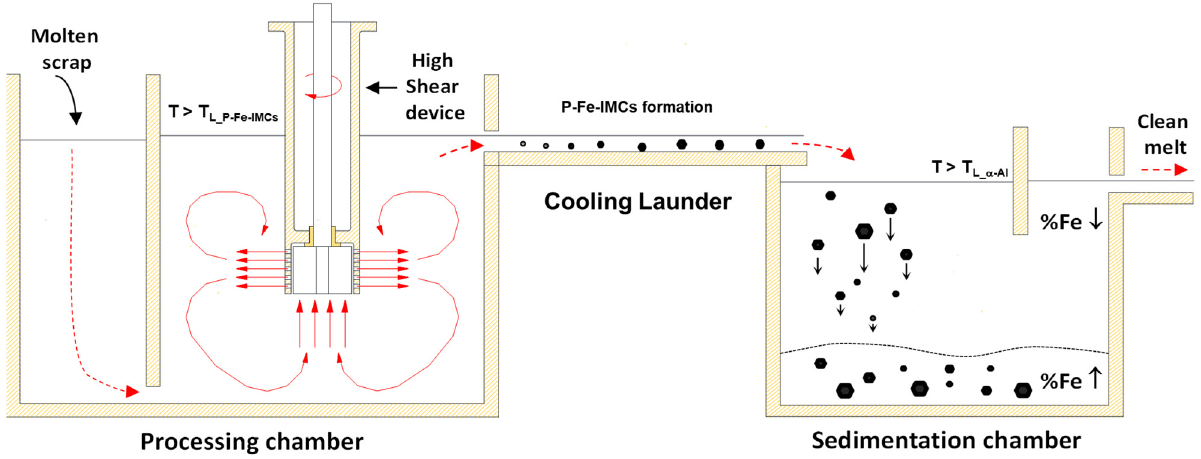
Figure 2. Schematic of the high shear melt conditioning (HSMC) technology for batch and continuous processing of aluminium alloy scrap for the removal of iron from the aluminium melts. The melt in the processing chamber is kept at high temperature, above the formation Once the melt is processed, there are two options to operate with the technology. On the one hand, the chamber can be tilted to pour the melt to another crucible in a furnace case of the A380 alloy (Figure 1d), this implies at least 650 ◦ C for an Fe content up to 2%.